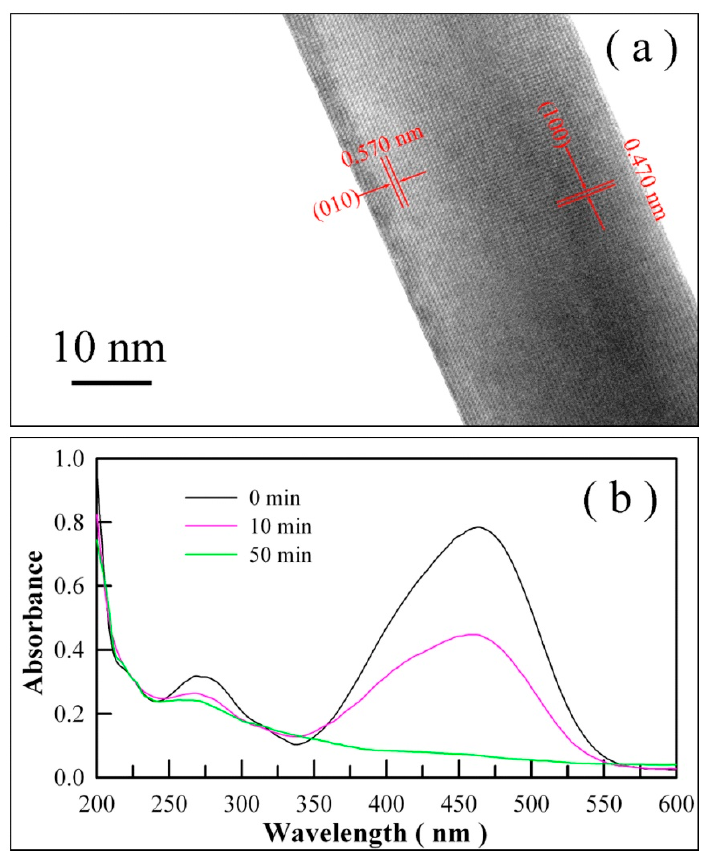
Figure 18. ( a ) High-resolution TEM micrograph of one ZnWO 4 nanoplate with a {001} facet; ( b ) absorption spectra of methyl orange solution as a function of UV irradiation time in the presence of ZnWO 4 nanoplates with a {001} facet.